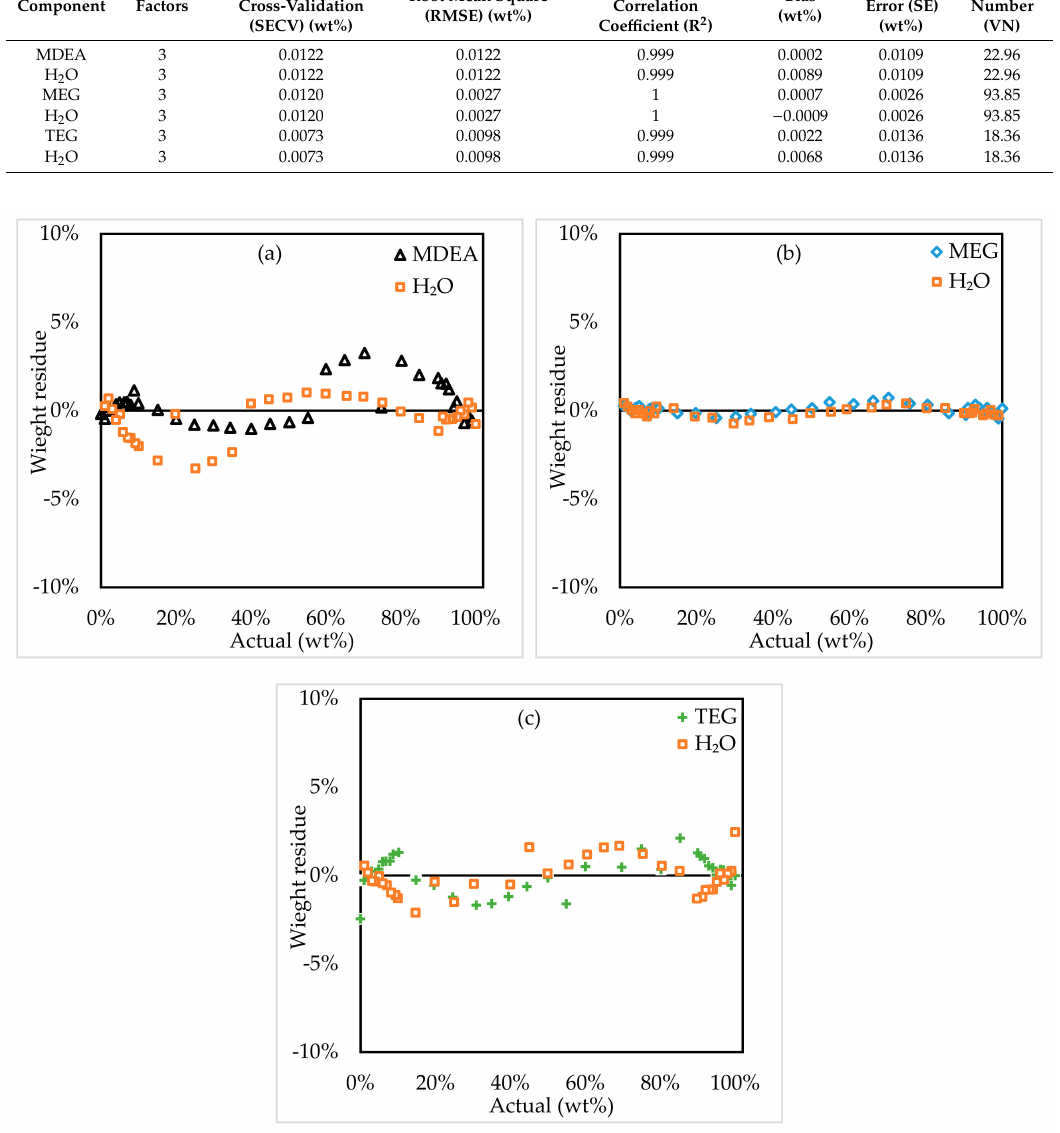
Figure 4. Weight residual of two-component systems; the MDEA-H 2 O system ( a ), MEG-H 2 O system ( b ), and TEG-H 2 O system ( c